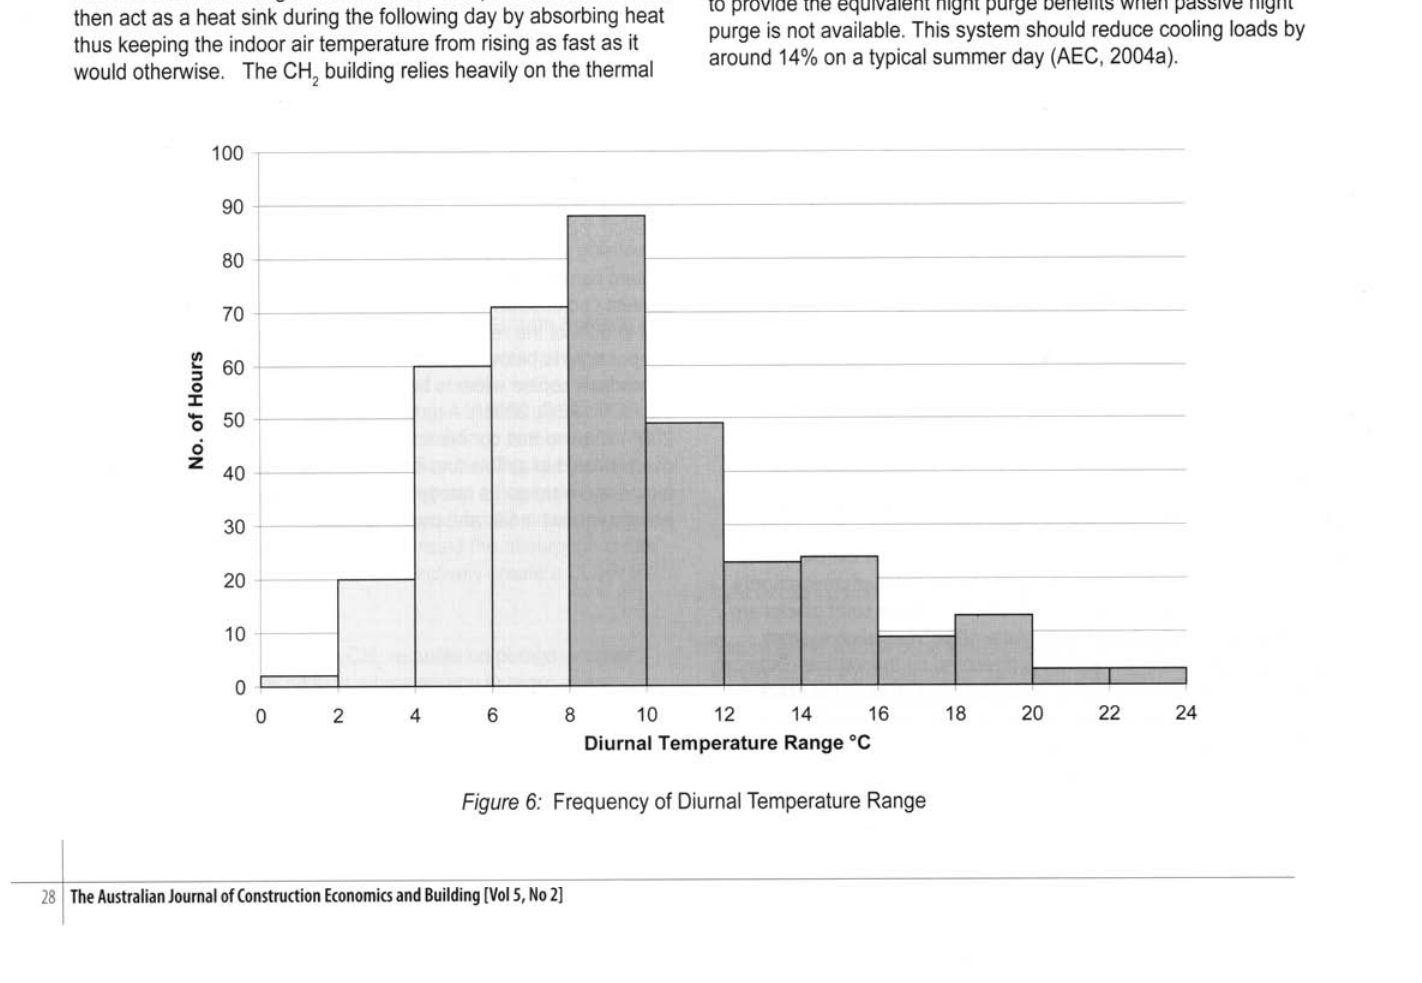
Figure 6: Frequency of Diurnal Temperature